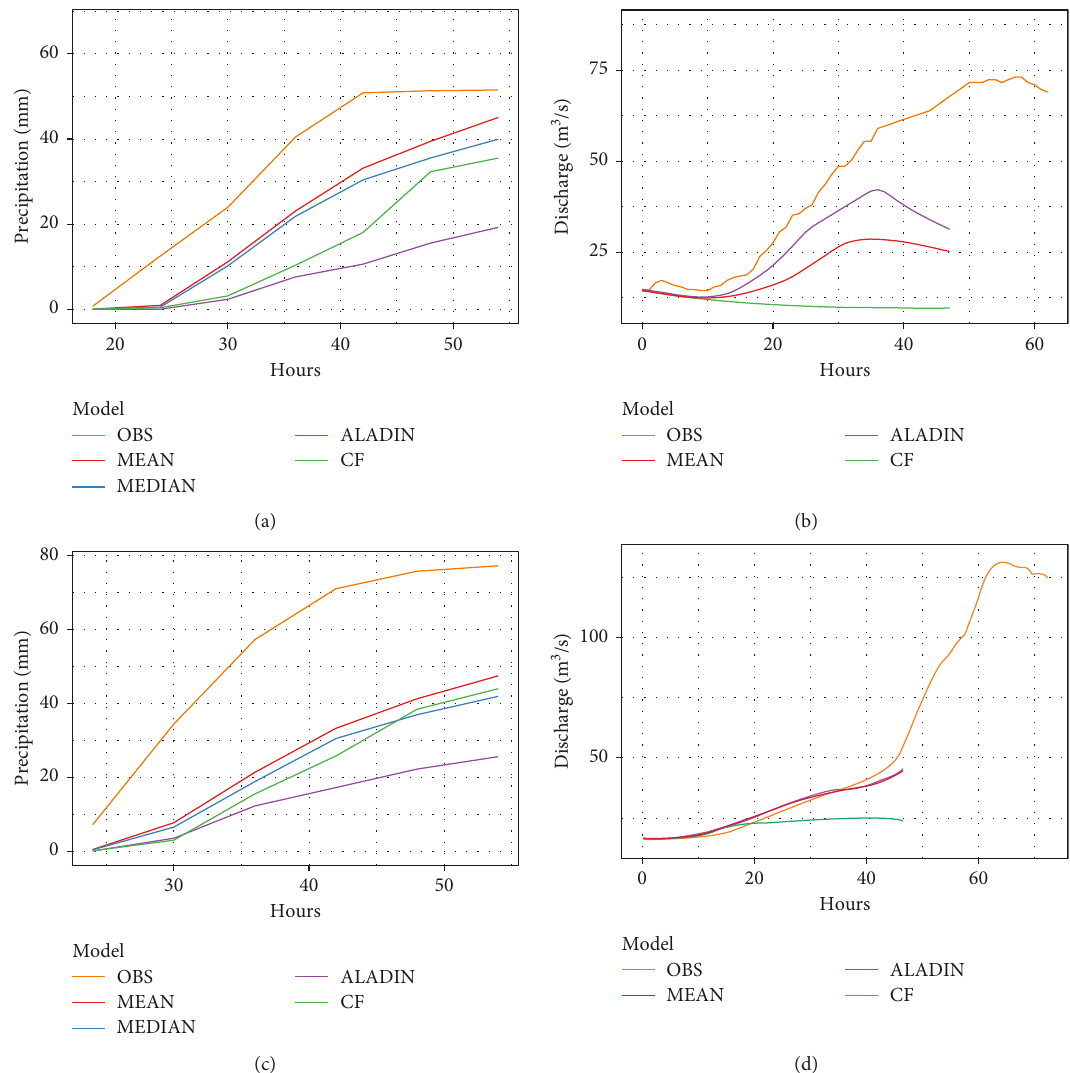
Figure 9: Comparison of ALADIN (purple), MEAN (red), MEDIAN (blue), CF (green), and measured data-OBS (orange). Lines with measured flows are extended to the culmination time. (a) region k, (b) L´asenice, (c) region i, and (d) Pilaˇr. Table 2: Hydrological characteristics for regions “k” and “i” during the flood event on 3 June 2013. Observed ALADIN- ALADIN-LAEF ALADIN-LAEF Gauging Gauging Region rainfall (mm) CZ (mm) MEAN (mm) maximum (mm) station/river